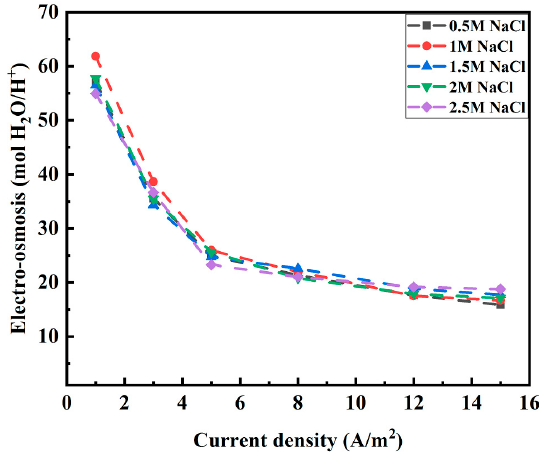
Figure 3. Electro-osmotic water-delivery quantity, t w (mol H 2 O/H + ) measured at different NaCl density differences and at various ampere densities. Table 1. Water-delivery data for NaCl of various densities.